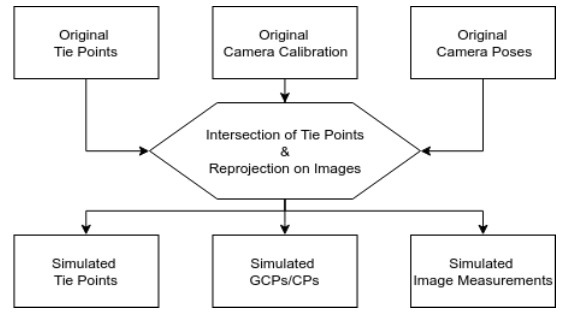
Figure 2. Workflow of the generation of simulated dataset.